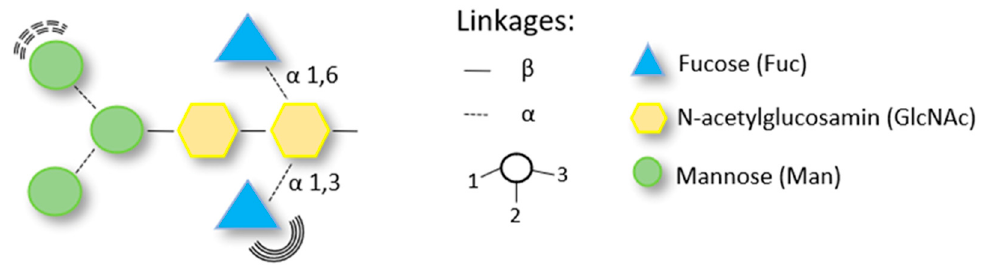
Figure 6. Insect venom N-glycan